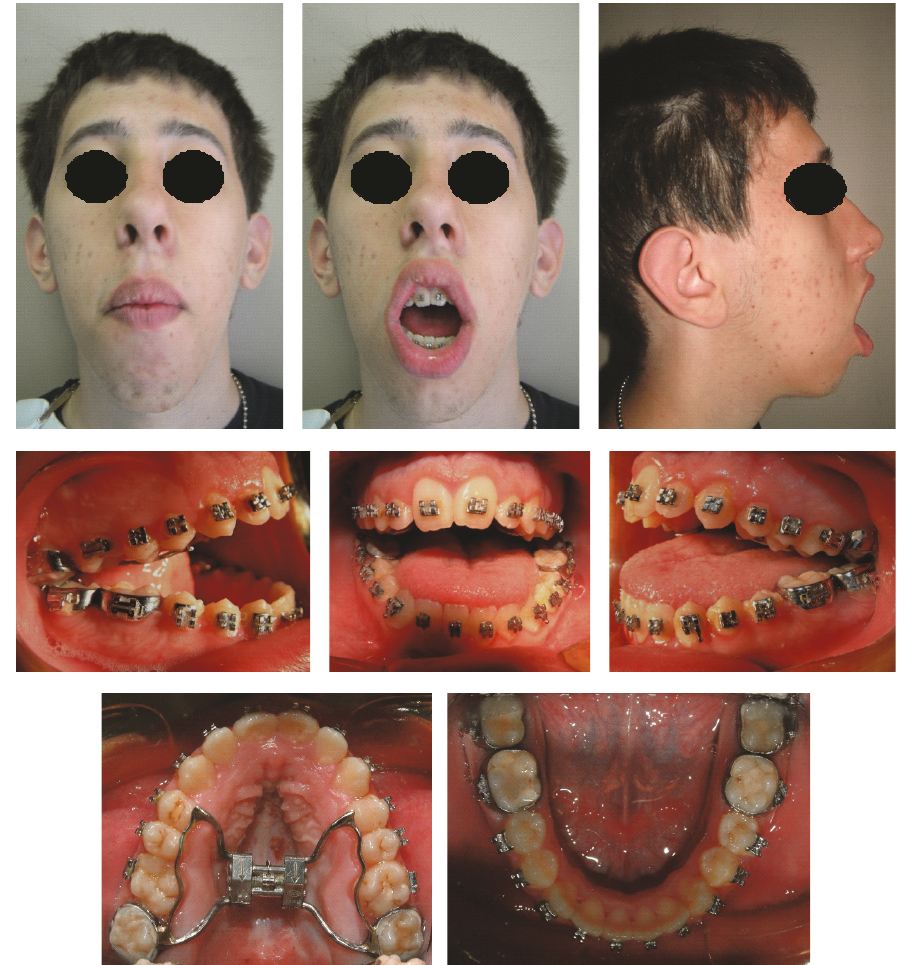
Figure 4: Extraoral and intraoral photographs before surgery.